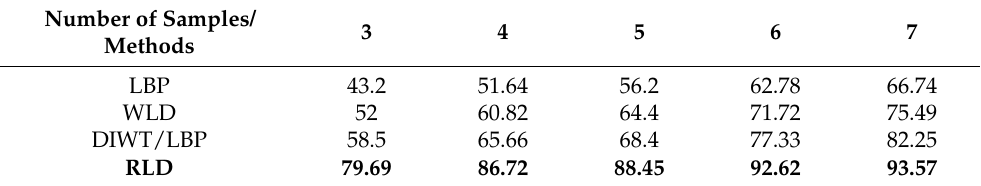
Table 3. Recognition rates for different methods using the FEI database (%).